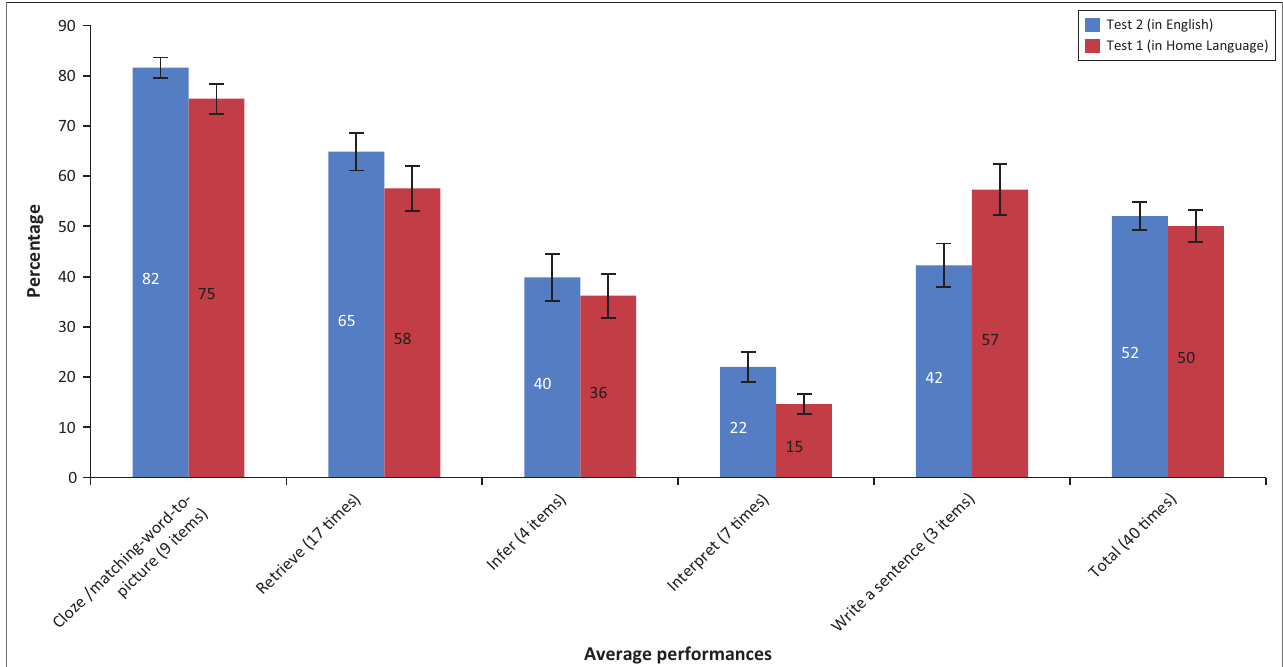
FIGURE 3: Average performance ( % ) in Test 1 (Systemic Evaluation) and Test 2 (National School Effectiveness Study) by literacy process for students whose home language is English ( n =